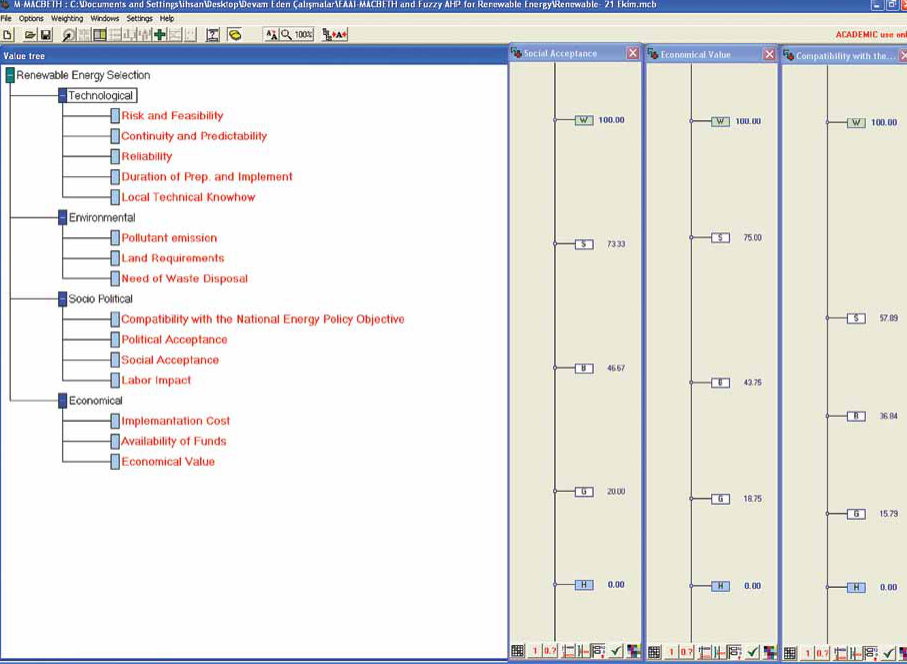
Fig. 4. The results for selected